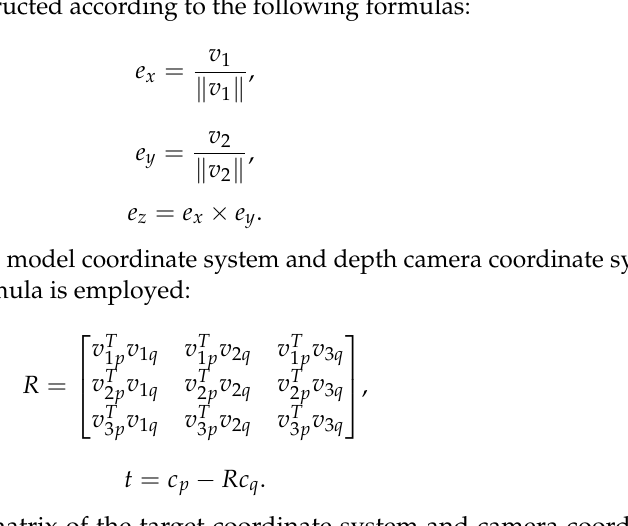
Figure 5. Depth camera calibration scenario. The ICP algorithm is used to register the point cloud of the calibration plate, and the coordinate transformation matrix between the two depth cameras is obtained. The cali ‐ bration plate is rotated, and the process is repeated until the exact position and pose of all ToF cameras are obtained. In Figure 6, the point clouds of the calibration plate scanned by the depth camera in different directions are indicated by different colors.